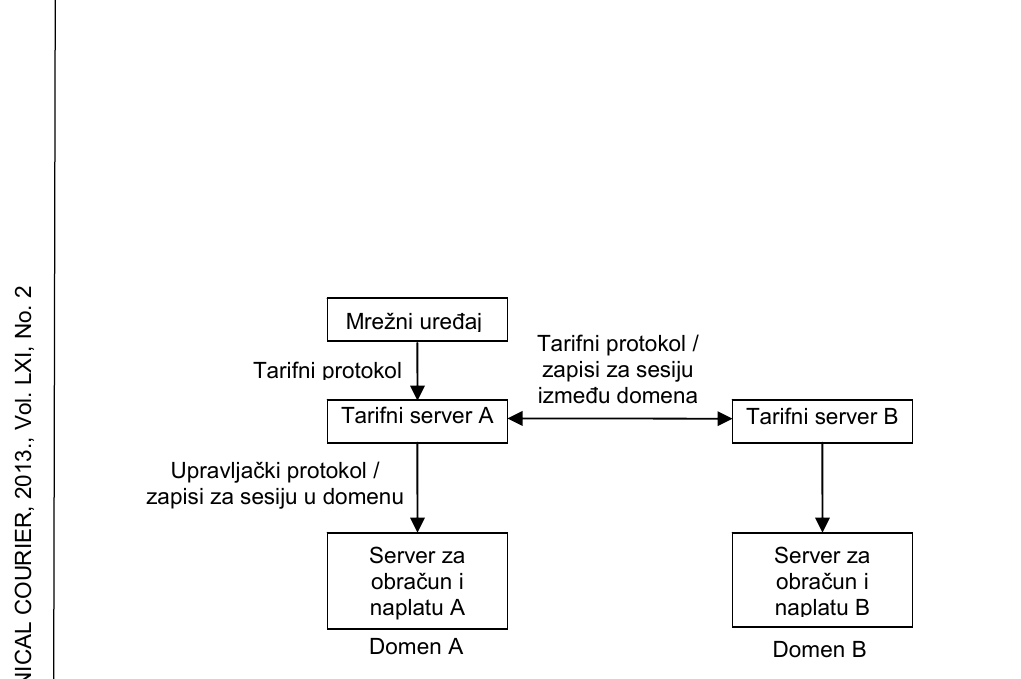
Figure 1 – IETF accounting management